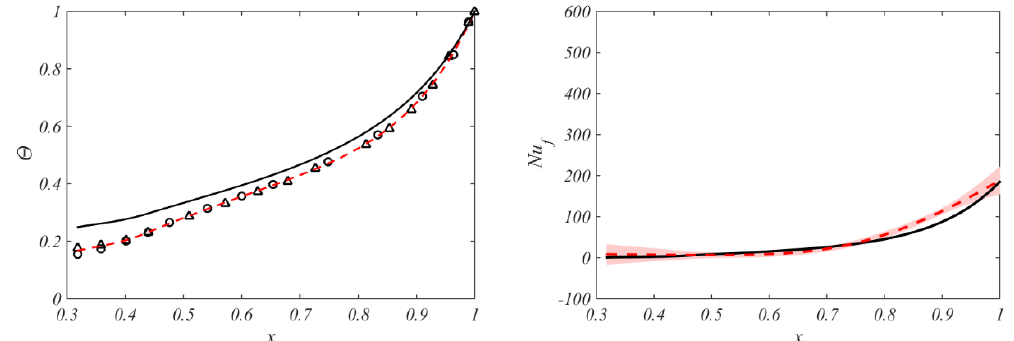
Figure 11. Distributions of nondimensional temperature and Nusselt numbers for Case c1 ( Ro ≈ 0.2, Gr f = 4.2 × 10 11 , Re ϕ = 3.0 × 10 6 , Re z = 2.5 × 10 4 ). Solid lines are theoretical curves; broken lines are results from Bayesian model, and shading shows uncertainty in Nu; symbols denote temperature measurements [6].